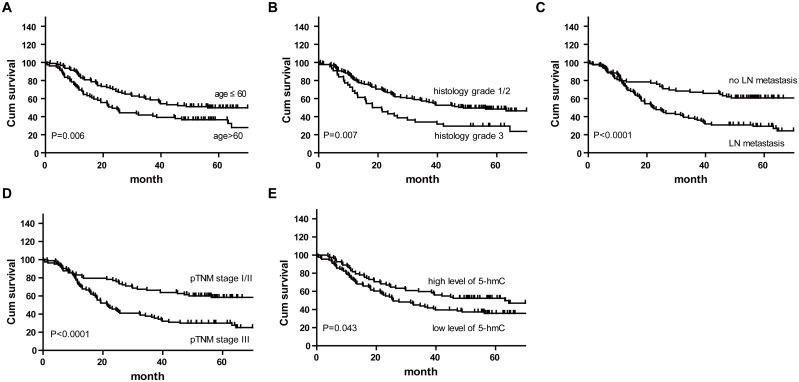
Associations between clinical parameters and overall survival.Kaplan-Meier analysis showed that older age (A), poor differentiation (B), lymph node metastasis (C), advanced pTNM stage (D) and negative 5-hmC expression (E) were significantly associated with poor overall survival among patients with ESCC.